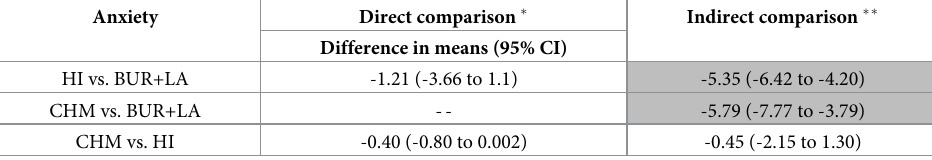
� Random effects model,—Inverse variance method; DerSimonian-Laird estimator for tau^2; I^2 = 98.7% (97.3%– 99.4%). �� Fixed effects model, Model fit: residual deviance; DIC = 19.44. Each chain used 80,000 iterations with a burn-in of 10,000 and a tinning interval of 20. Negative values represent a decrease in the anxiety levels. Highlighted cells represent contributions from indirect comparisons.